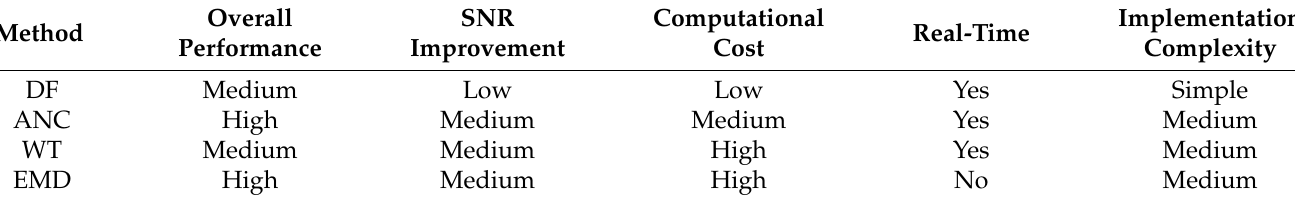
Table 5. Summary of the ERG signal processing methods.